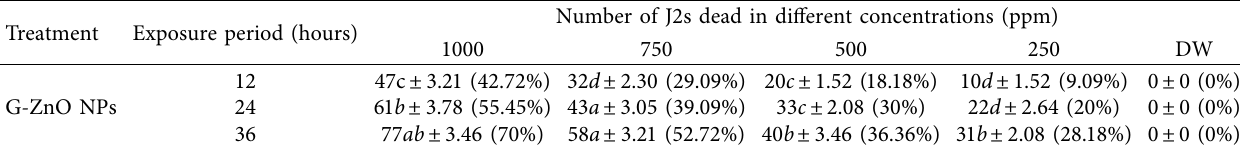
Table 2: Efect of various concentrations of G-ZnO NPs on the mortality of J2s of M. incognita after 12, 24, and 36hours of the exposure period in vitro .